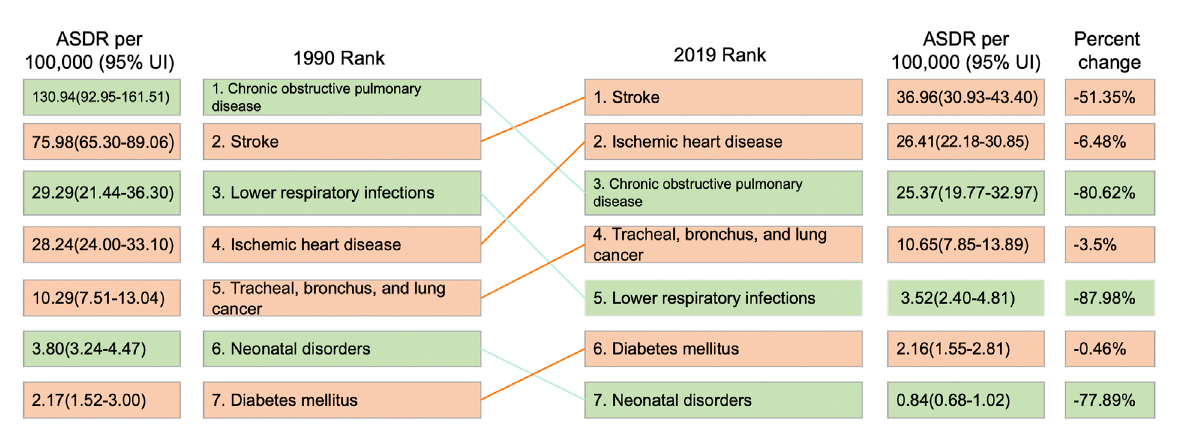
FIGURE 3 ASDR, ranking, and percent change of top seven diseases caused by air pollution in China in 1990 and 2019 (per 100,000). The ASDR of seven kinds of diseases caused by air pollution is ranked. Green block shows the diseases with decreased ranking and the orange block shows thediseases with increased ranking.